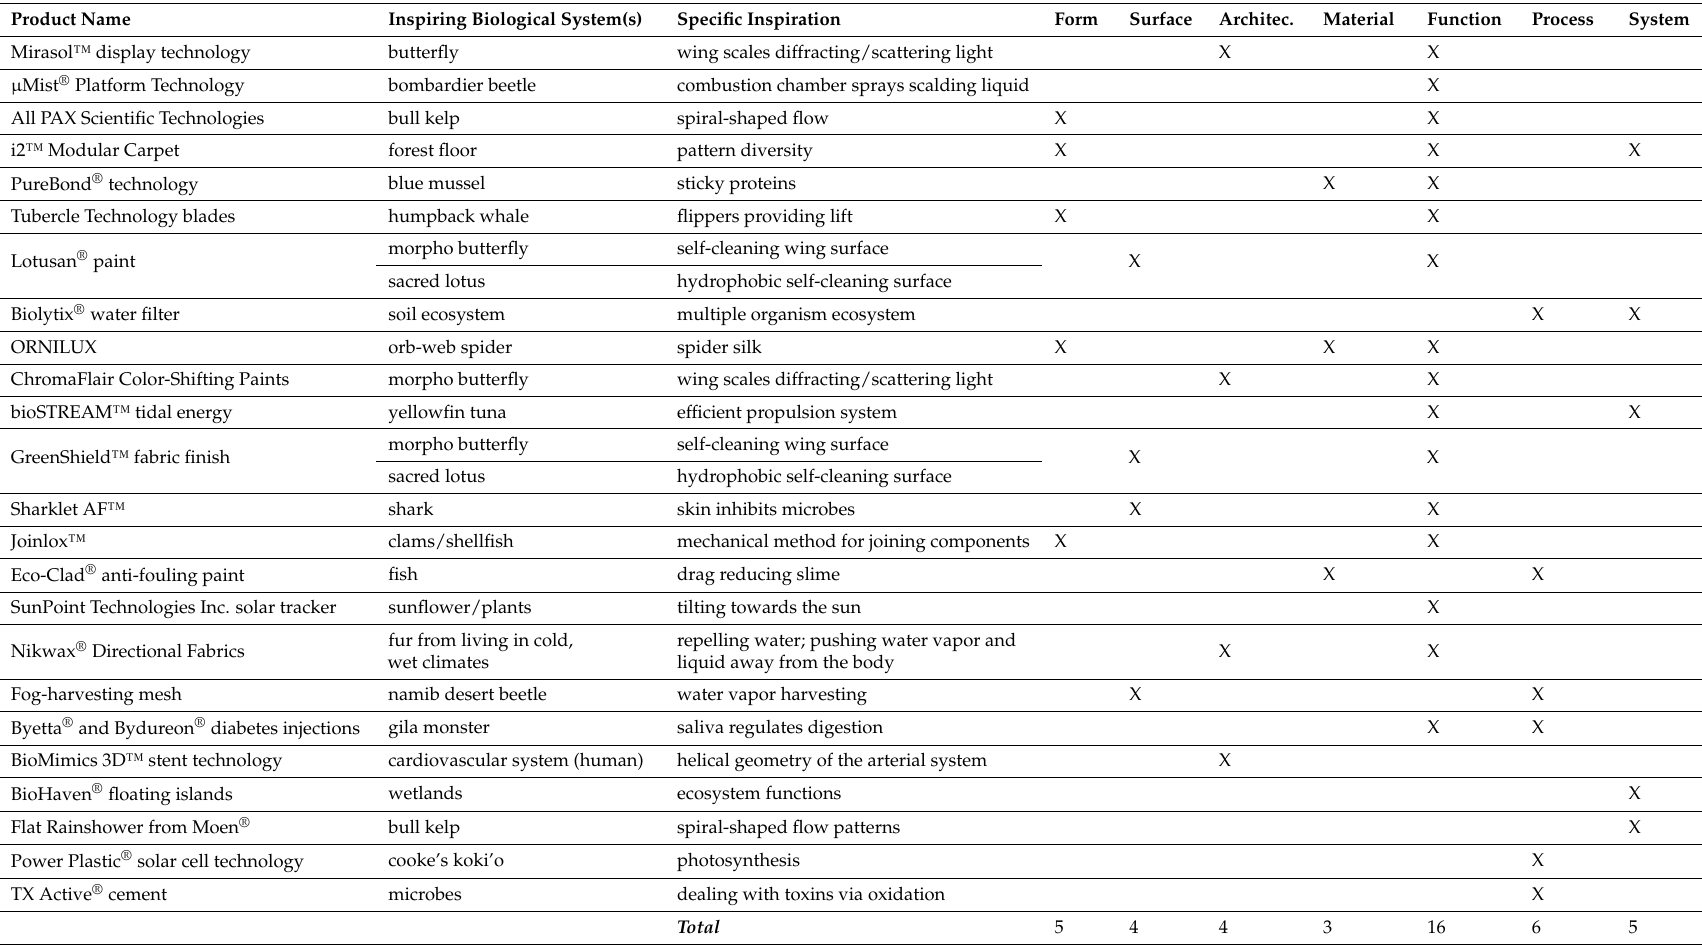
Table 3. Analogy Categories Applied to Commercialized Products in the AskNature